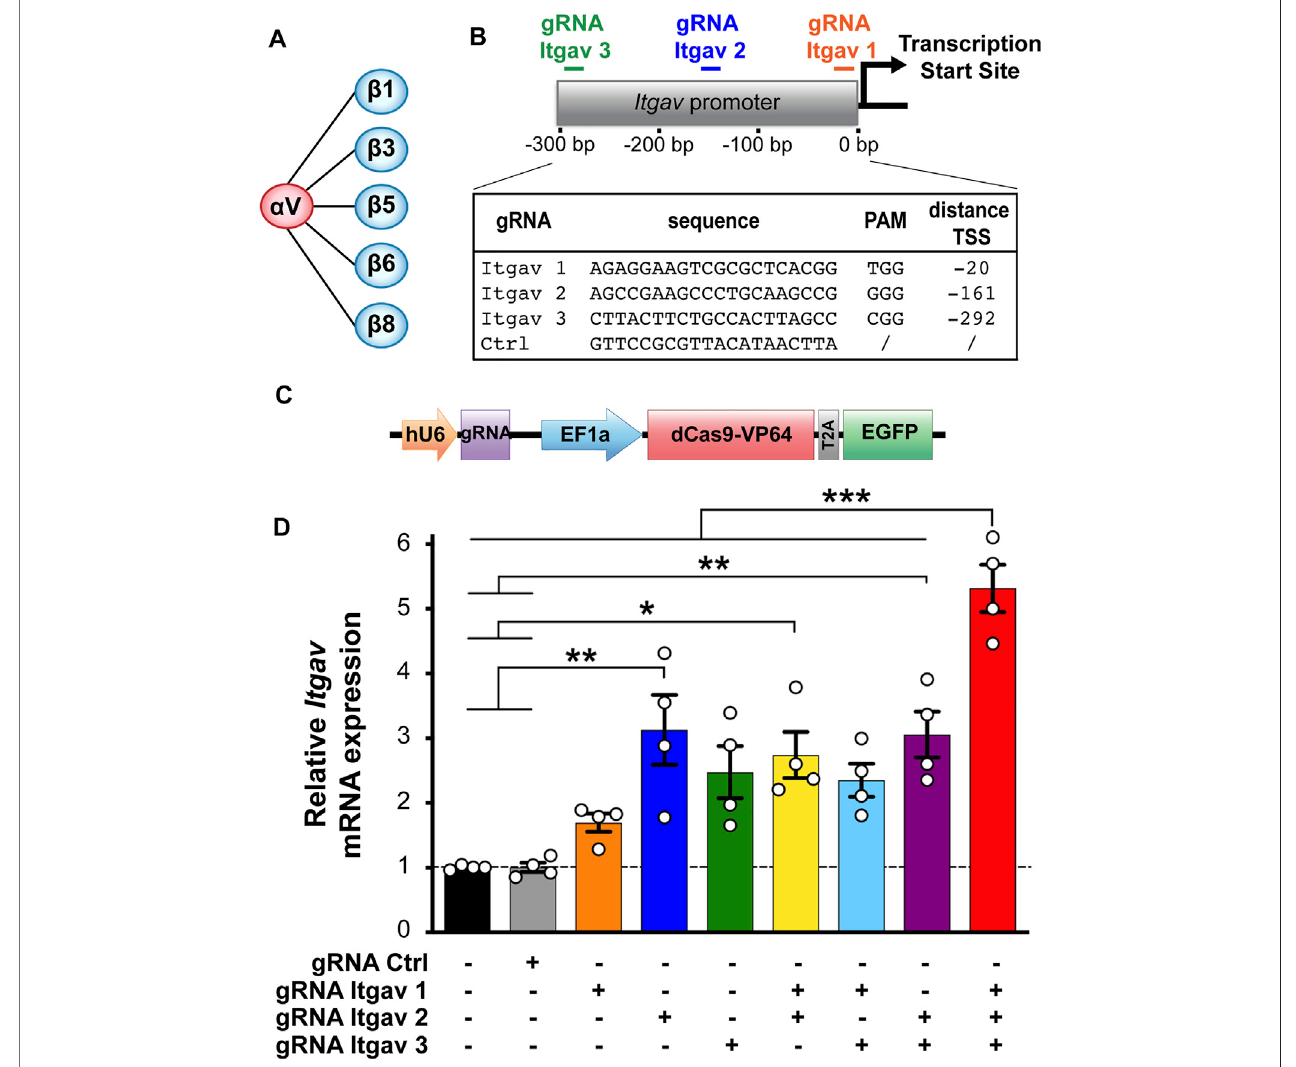
FIGURE 1 | CRISPRa enhances expression of α V integrin subunit in N2a cells. (A) α V integrin receptor family. (B) gRNA sequences and position of their targets on the Itgav promoter. (C) ConstructusedfortransfectingmurineN2acells,containingacassetteforexpressingthegRNAandoneforexpressingdCas9-VP64andEGFP. (D) Quanti fi cation of α V integrin mRNA levels in N2a cells 24 h after transfection with the indicated constructs. mRNA expression was normalized to the values of non- transfected samples within the same RT-qPCR plate. * p < 0.05, ** p < 0.01, *** p < 0.001, one-way ANOVA followed by Tukey ’ s post-test ( n = 4 independent